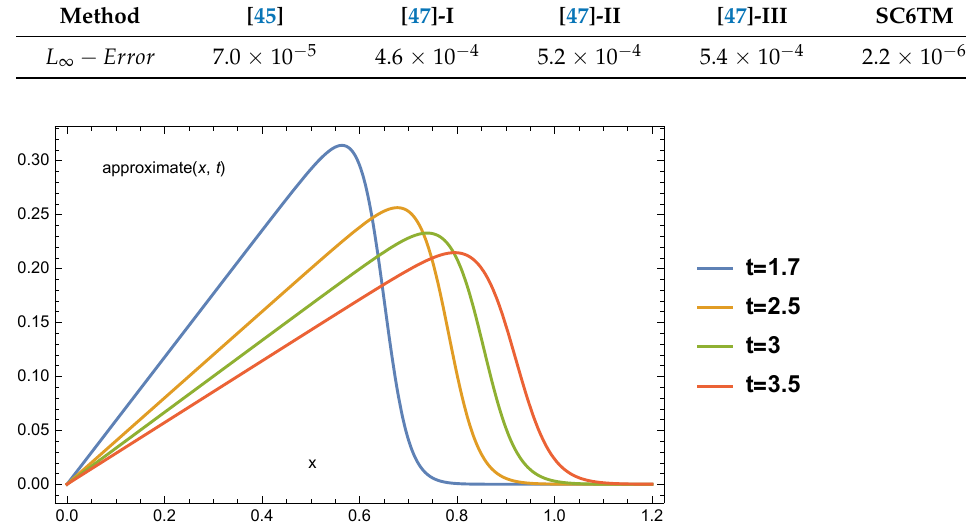
Table 3. Comparison between different errors of Example 4, when t = 3.6. Method